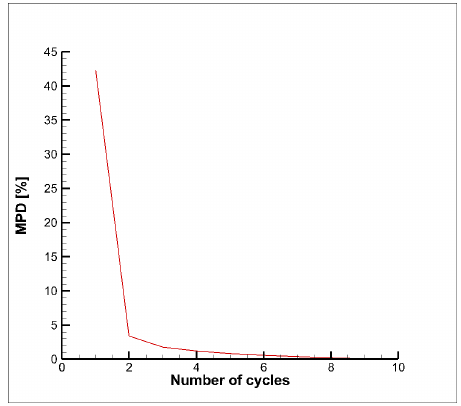
Figure 10. Maximum percentage difference MPD.